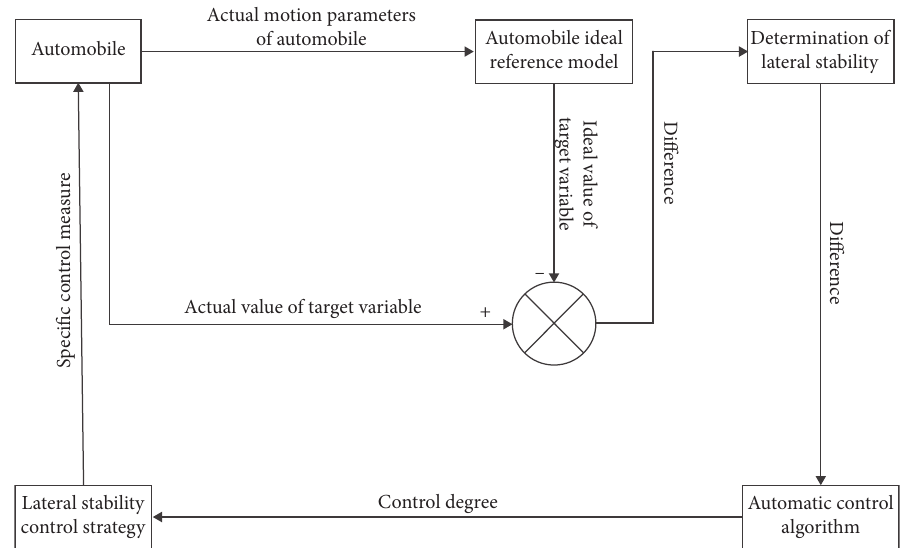
Figure 3: The overall structure of the vehicle lateral stability controller.